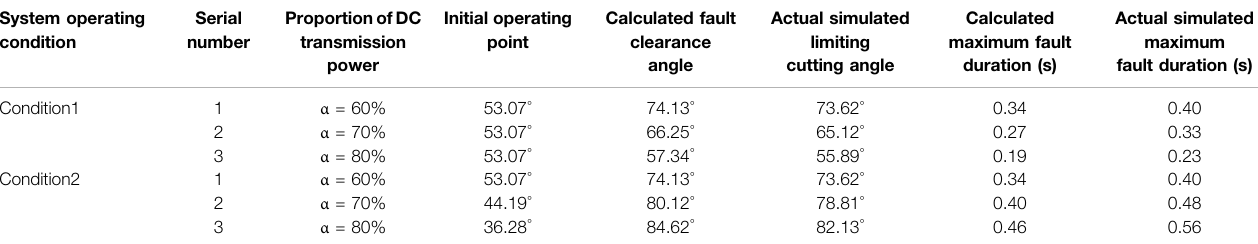
TABLE 1 | Calculation and simulation results of limit cutting angle and maximum fault duration of hybrid system under different operating